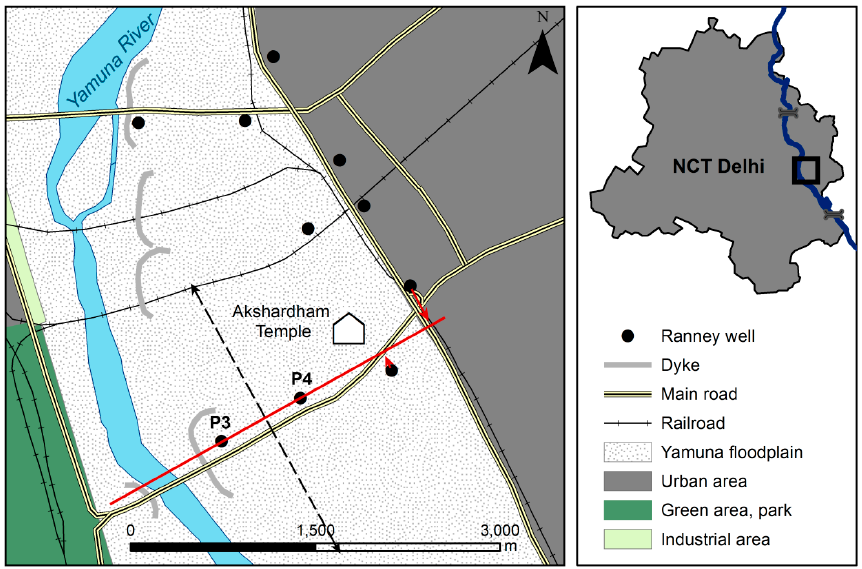
Figure 2. Overview of the study area, location of the modeled x -section (red line), and the model extent in the y -direction (dashed arrows).